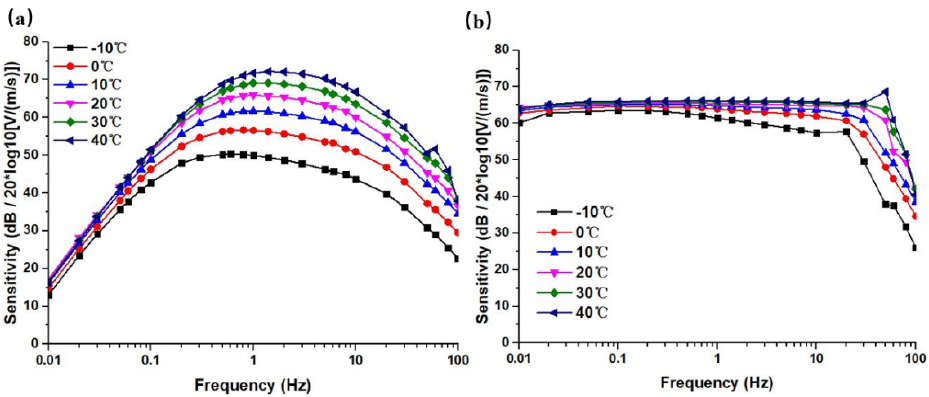
Figure 5. ( a ) The output voltage of the seismic sensor under the input velocity of 0.07 mm/s @1 Hz and with the temperature of 10 °C ( b ) The power spectrum signals of the test results of sensitivity at 1 Hz under the temperature of 10 °C.